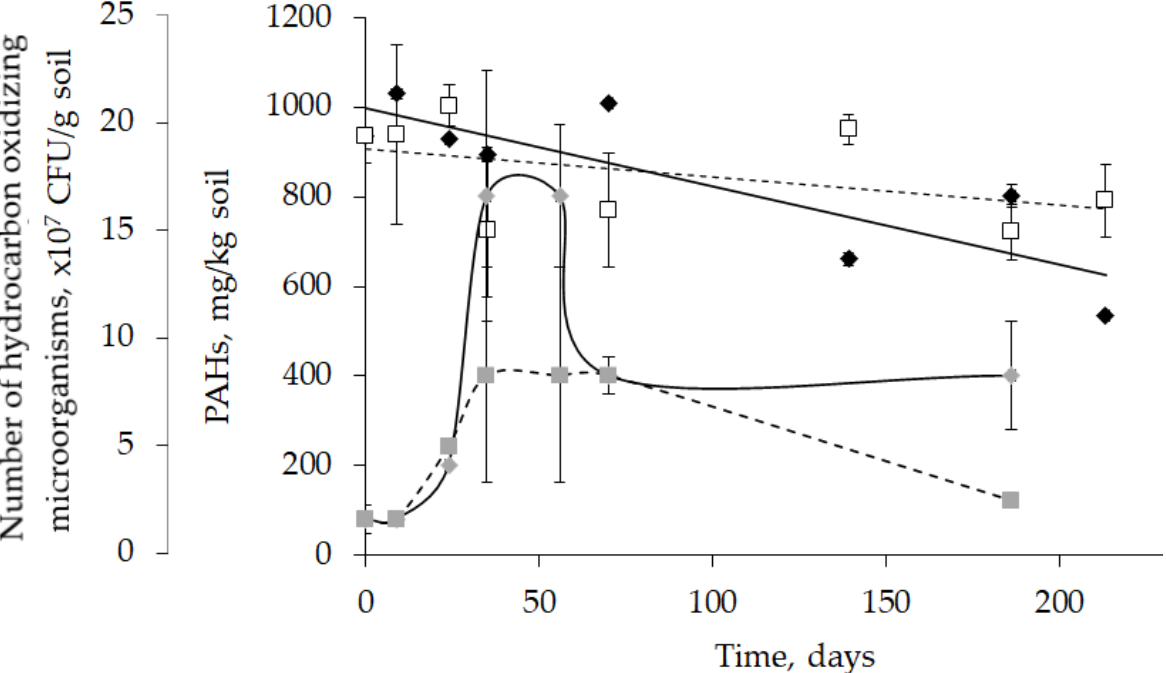
Figure 6. Dynamics of PAH concentration (two upper lines) and number of hydrocarbon-oxidizing microorganisms (two lower graphics) in model soil. Continuous lines correspond to model soil with introduced Rhodococcus cells, and dotted lines correspond to control soil without introduced Rhodococcus cells. Symbols: black diamonds—concentration of PAHs in soil with Rhodococcus ; grey diamonds—number of hydrocarbon-oxidizing microorganisms in soil with Rhodococcus ; white empty squares—concentration of PAHs in control; grey squares—number of hydrocarbon-oxidizing mi- croorganisms in control.